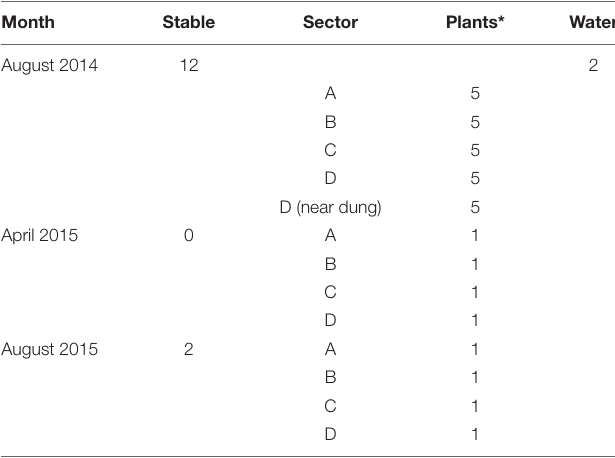
TABLE 1 | Number of samples taken at the Nijkerk cattle farm location in 2014 and 2015. Month Stable Sector